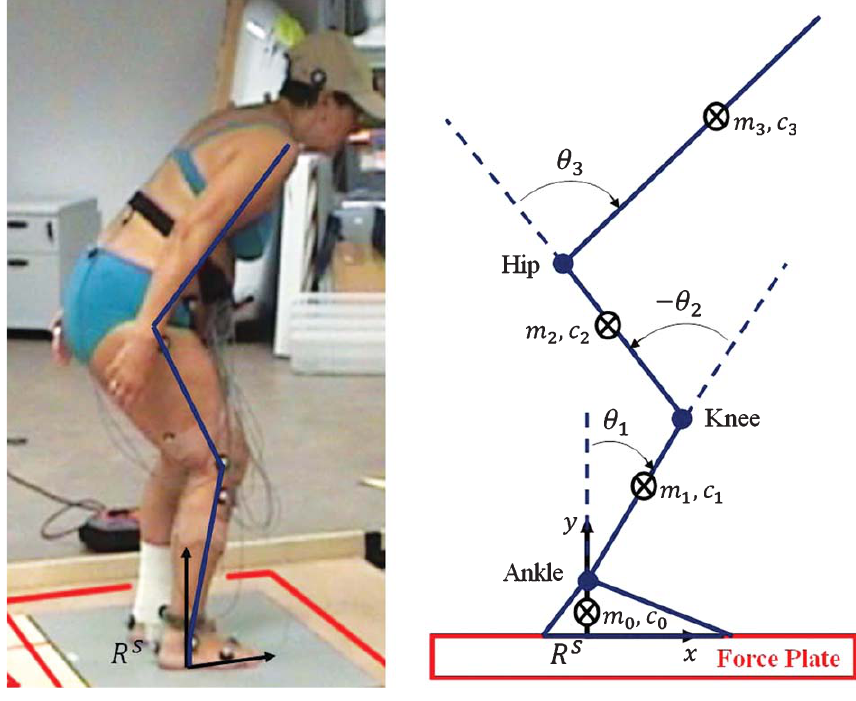
Fig. 6. Kinematic model of the subject used to produce the estimation of its